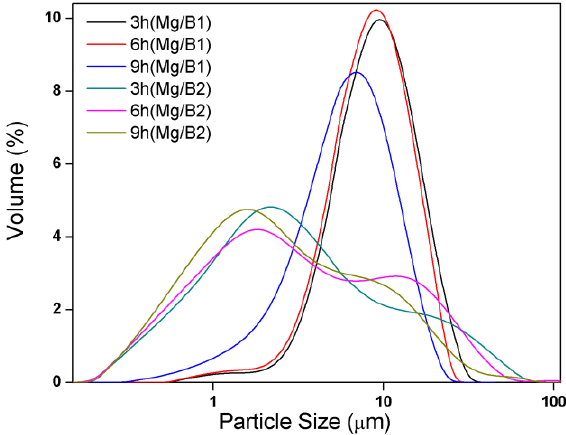
Figure 5. Particle size distribution of Mg/B composite